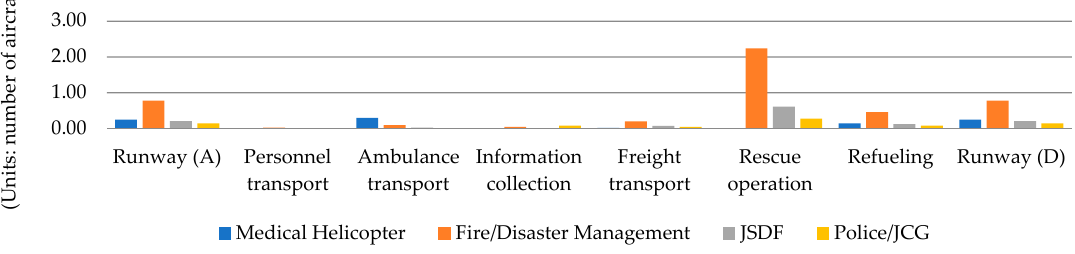
Figure 4. Expected number of each operator’s aircraft waiting in the queue in the system.